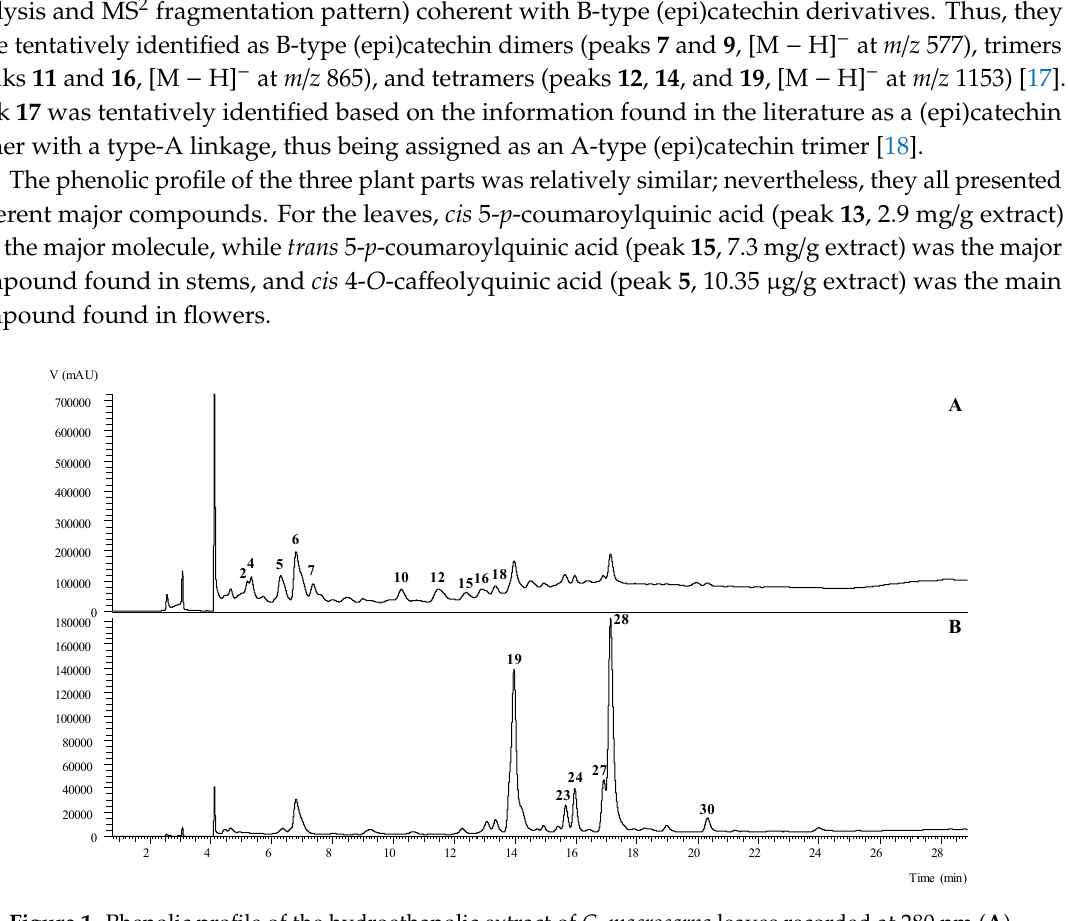
Figure 1. Phenolic profile of the hydroethanolic extract of C. macrocarpa leaves recorded at 280 nm ( A ) and 370 nm ( B ) obtained by HPLC-DAD/ESI-MS.